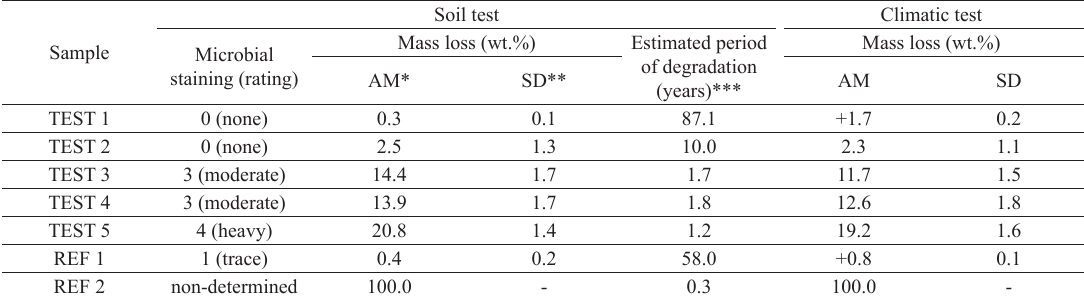
Table 4. The results of visual assessment of microbial staining (growth) according to ASTM G160-03 11 and the relative mass loss after 3 months of the open-air soil test, and the relative mass loss after 192 hours of the climatic test. Soil test Climatic test Mass loss Sample Microbial staining (rating)